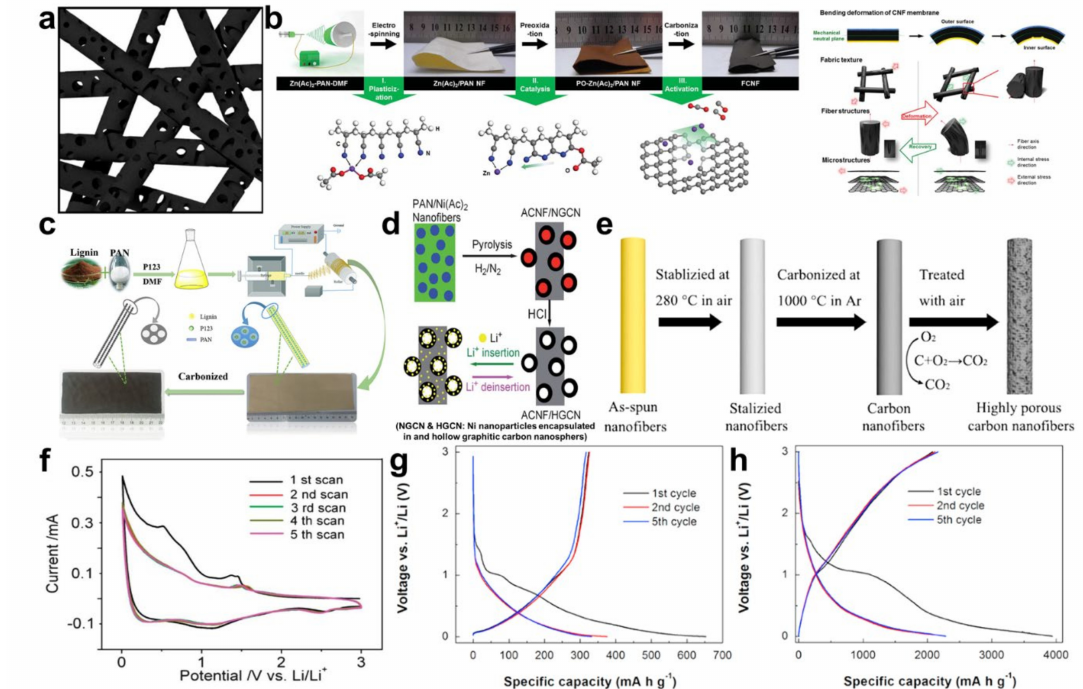
Figure 4. Porous carbon nanofiber anode materials. ( a ) Schematic illustration of porous